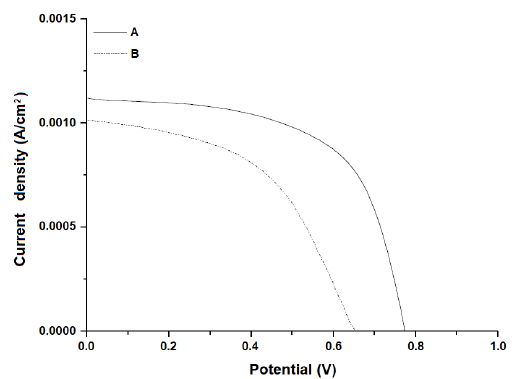
Figure 4. j x V curves resulting from cells employing platinum (A) and graphite (B) electrodes. Other conditions: electrolyte: tetrabutylammonium iodide (0.05M) / I substrate: FTO; Photoanode: TiO